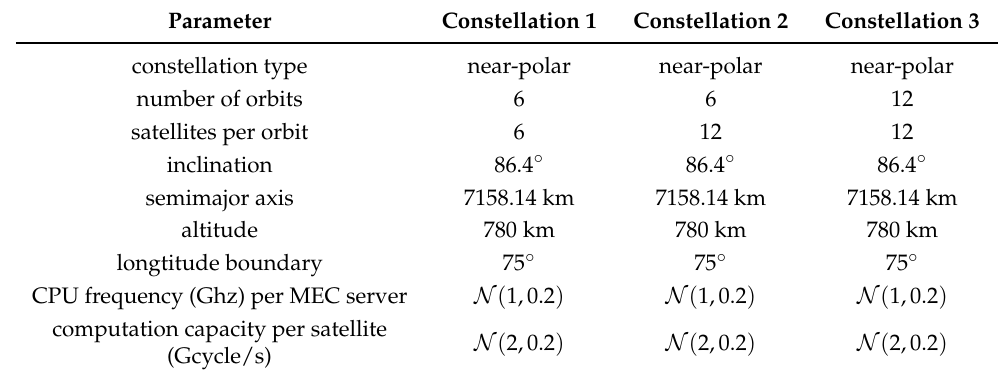
Table 3. Constellation parameters.